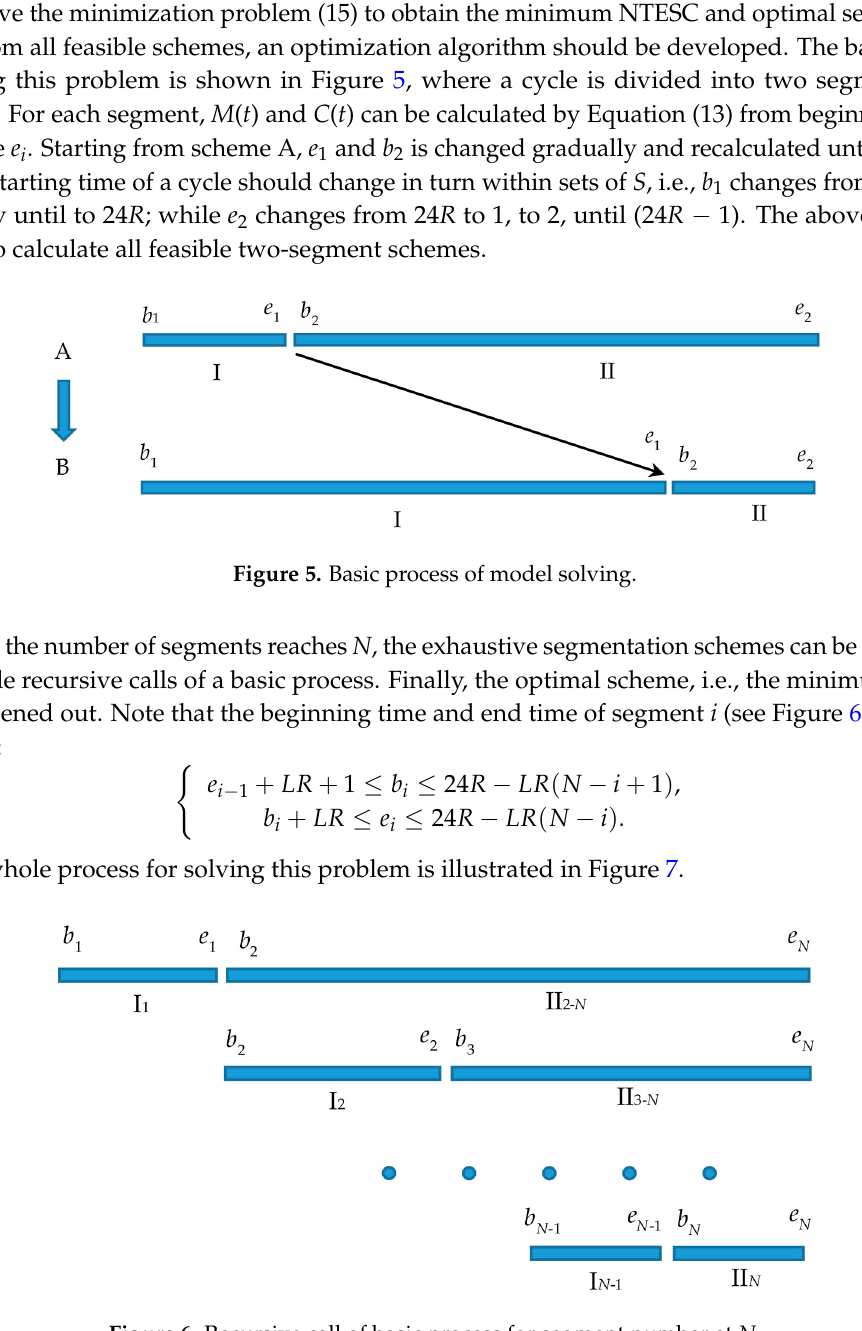
Figure 6. Recursive call of basic process for segment number at N .